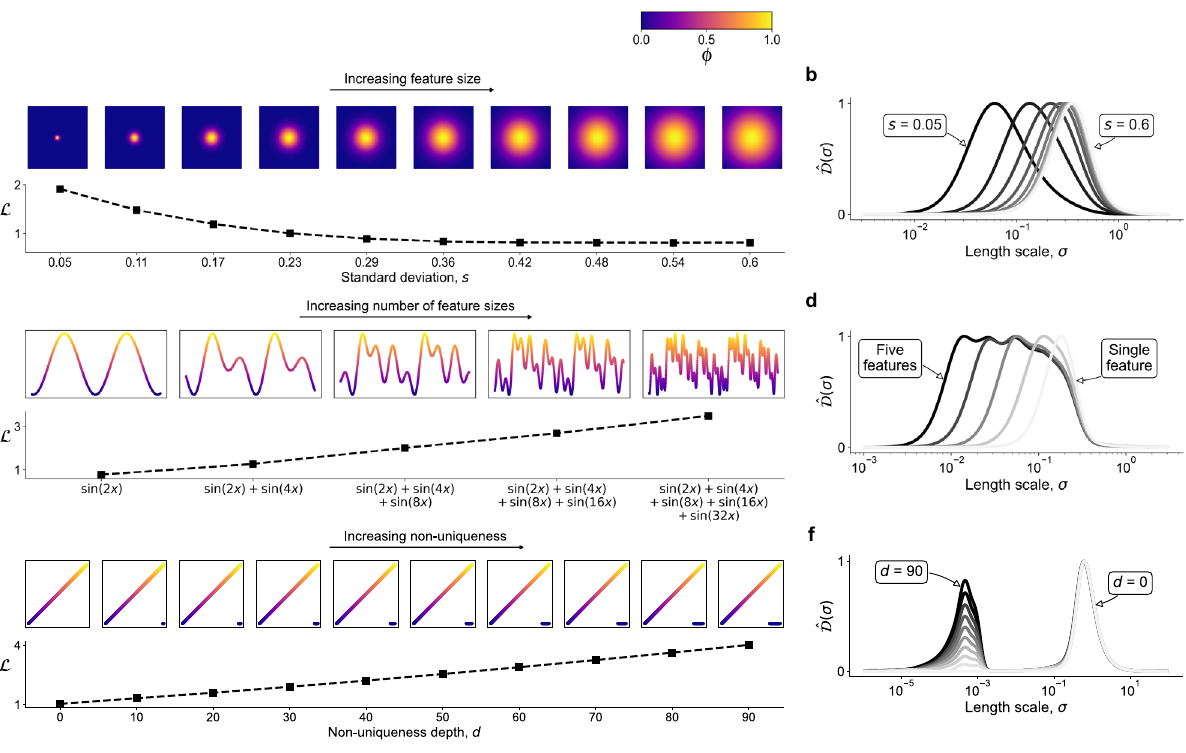
Figure 3. Cost function behavior on toy functions. ( a ) The response of the cost function to increasing feature size. The dependent variable φ is generated from the bivariate Gaussian normal distribution with varying standard deviation, s . ( b ) The ˆ D (σ) curves corresponding to functions with increasing feature size. The curves are plotted in gray-scale denoting an increasing value of s from the darkest curve ( s = 0.05 ) to the lightest ( s = 0.6 ). ( c ) The response of the cost function to multiple feature sizes. The dependent variable φ is generated from a superposition of sine functions with varying frequencies. ( d ) The ˆ D (σ) curves corresponding to functions with increasing number of feature sizes. The curves are plotted in gray-scale, such that the darkest curve corresponds to five different feature sizes and the lightest curve corresponds to a single feature size. ( e ) The response of the cost function to increasing non-uniqueness. The dependent variable φ is generated as a linear function of x with an additional set of overlapping observations for which φ = 0 . ( f ) The ˆ D (σ) curves corresponding to functions with increasing non-uniqueness. The curves are plotted in gray-scale denoting an increasing value of the non-uniqueness depth, d , from the lightest curve ( d = 0 ) to the darkest ( d = 90 ). In all examples, the dependent variables, φ , have been normalized to a [0, 1]